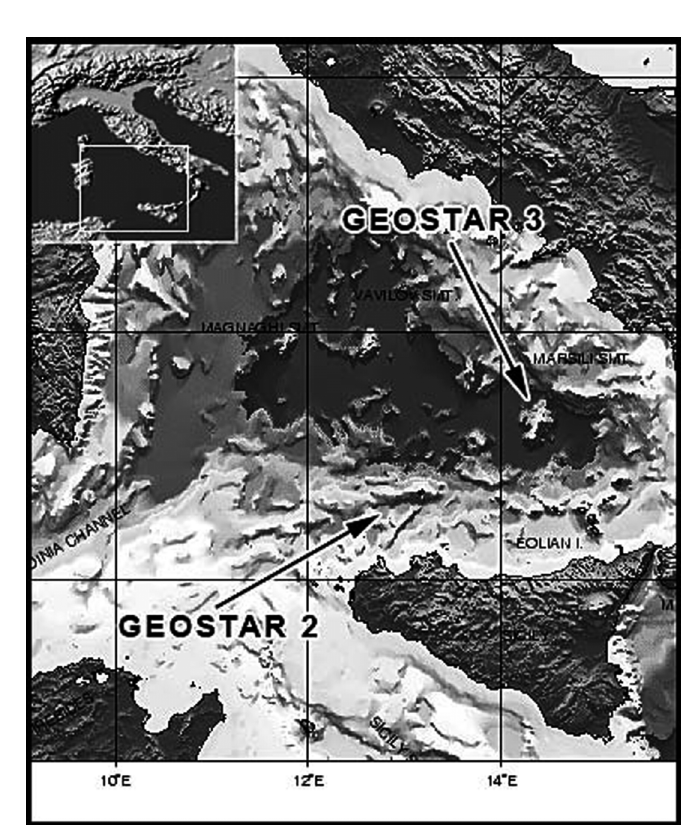
Fig. 1. Locations of the deployments of GEOSTAR bottom station in the Thyrrenian Sea. GEOSTAR 2 geo- graph. coord.: 38°32’24” N, 12°46’30” E; GEOSTAR 3 geograph coord.: 39°29’12” N, 14°19’52”